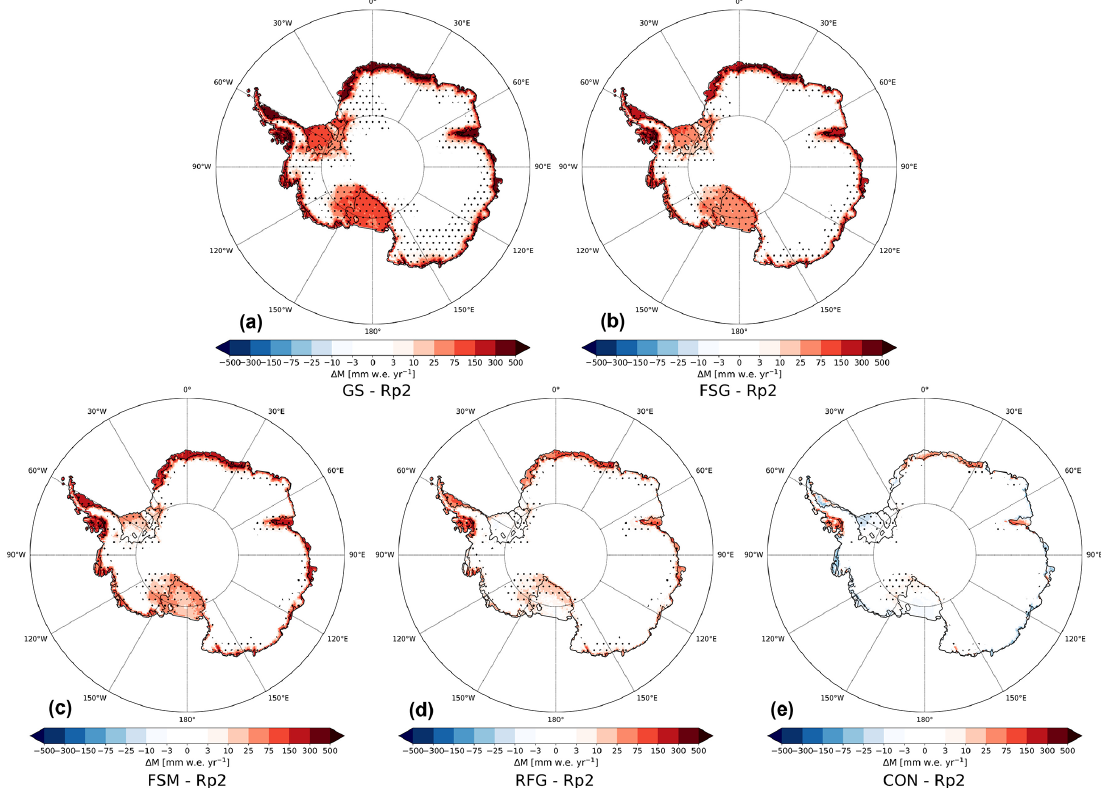
Figure 11. Mean yearly-accumulated melt difference with Rp2 in mmw.e.yr − 1 for (a) GS, (b) FSG, (c) FSM, (d) RFG and (e) CON for 1985–1990. Positive values show a melt increase with respect to Rp2. The dots represent significance.